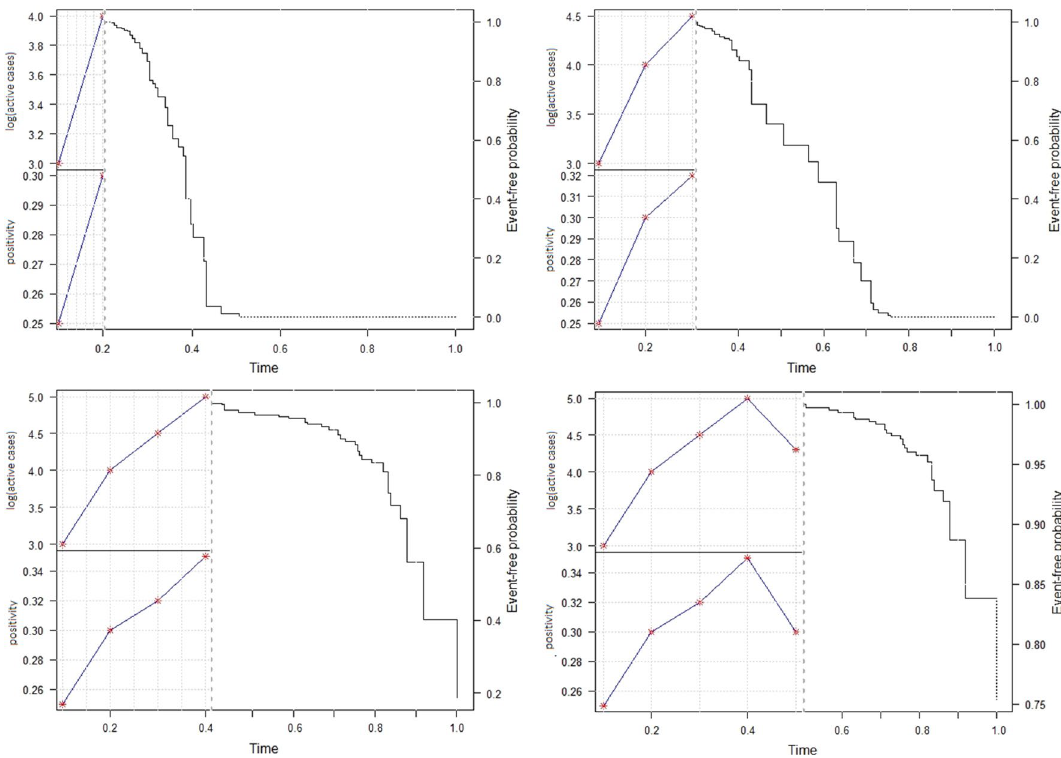
Figure 1. Dynamic predictions for commune of Santiago. The x-axis represents times. The y-axis of the left side represents the active cases in the logarithmic scale and the positivity. The stars represent the observed values and the solid line the fitted longitudinal trajectory. The y-axis on the right side represents the mean estimator of the